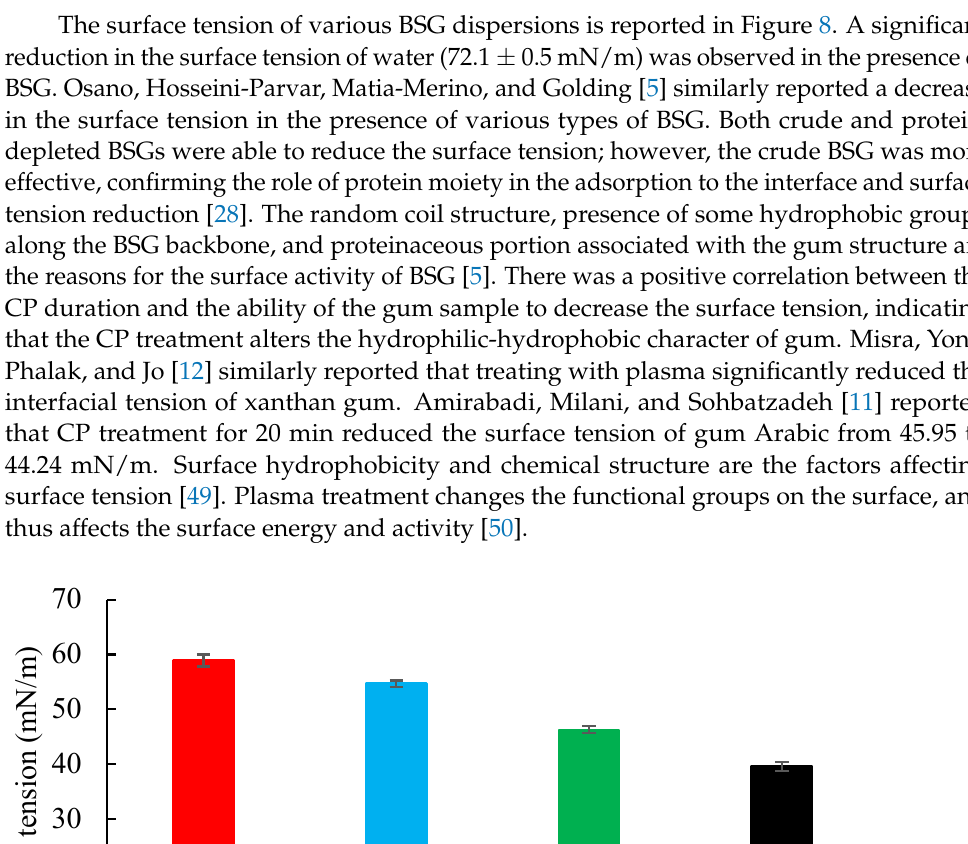
Figure 9. Appearance of ( a ) control modified BSG edible film and those incorporated with tannic acid and vitamin D 3 in ( b ) encapsulated form in nanophytosome and ( c ) free form.